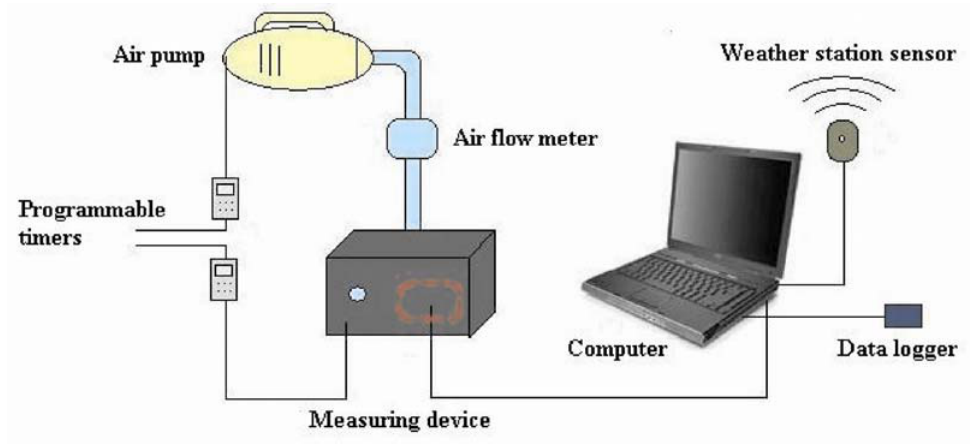
Fig 1. Scheme of radon progeny volumetric activity hourly measurement in air